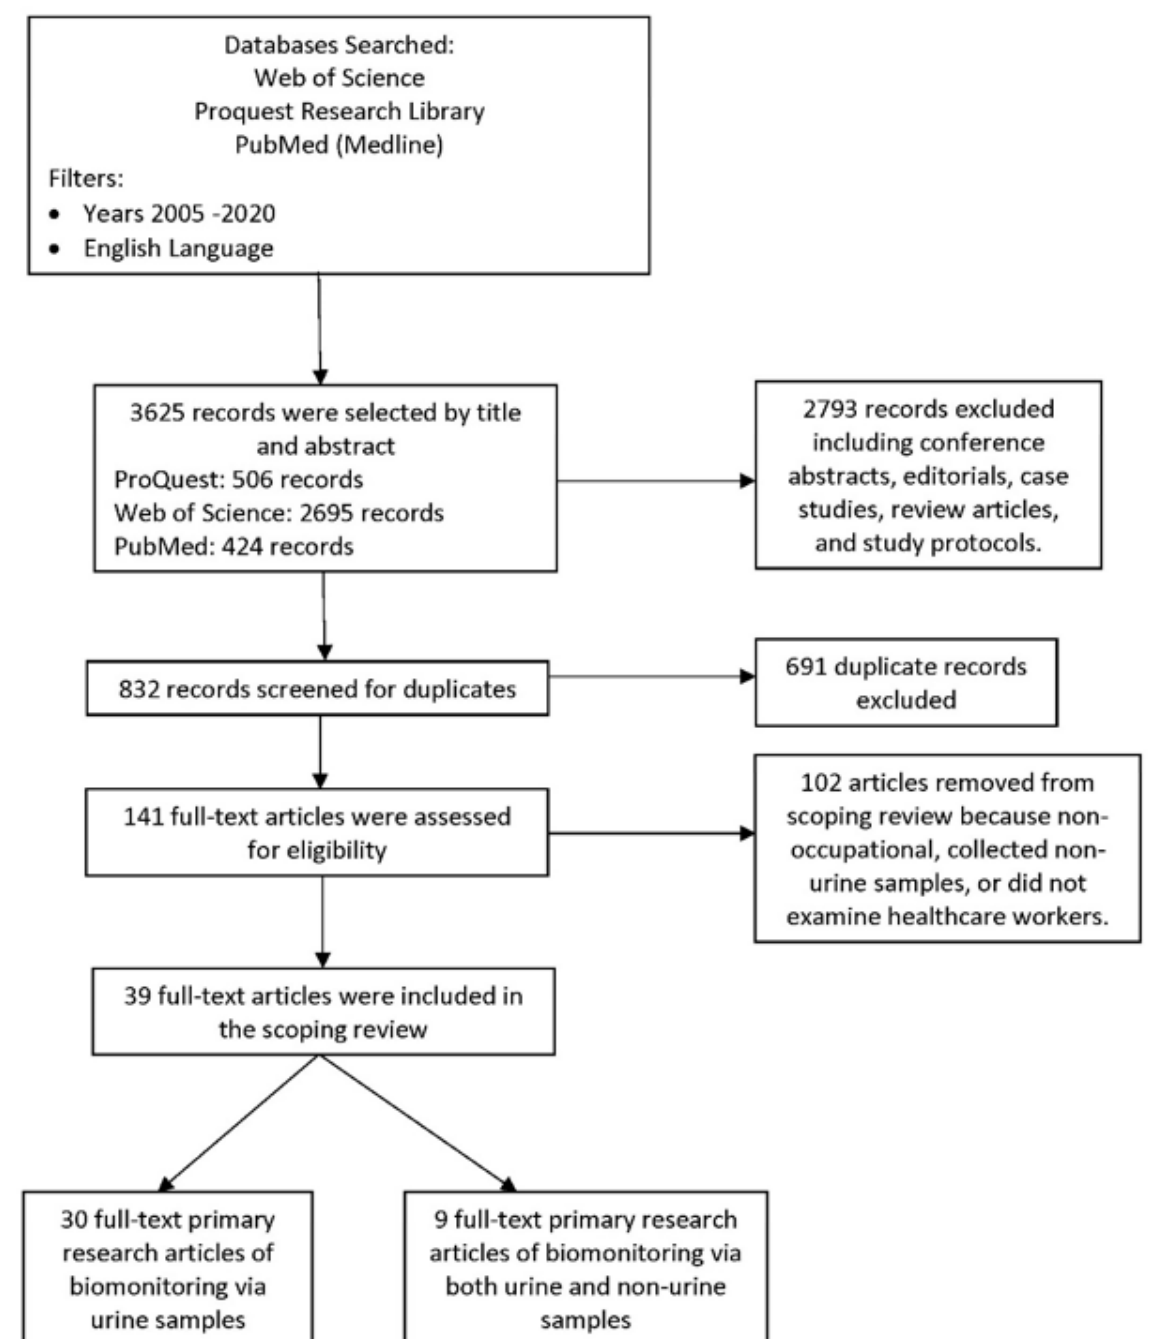
Figure 1. Flow diagram outlining the stepwise selection of studies included in the review.